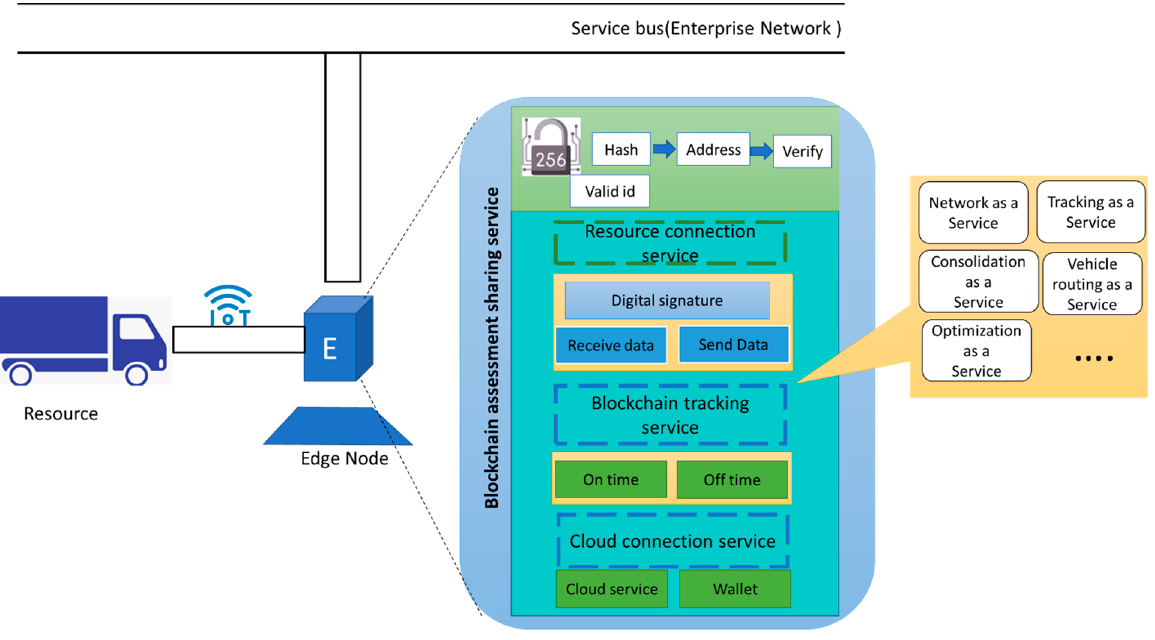
Figure 3. Blockchain asset sharing service: The driver can use a mobile application to connect OL.